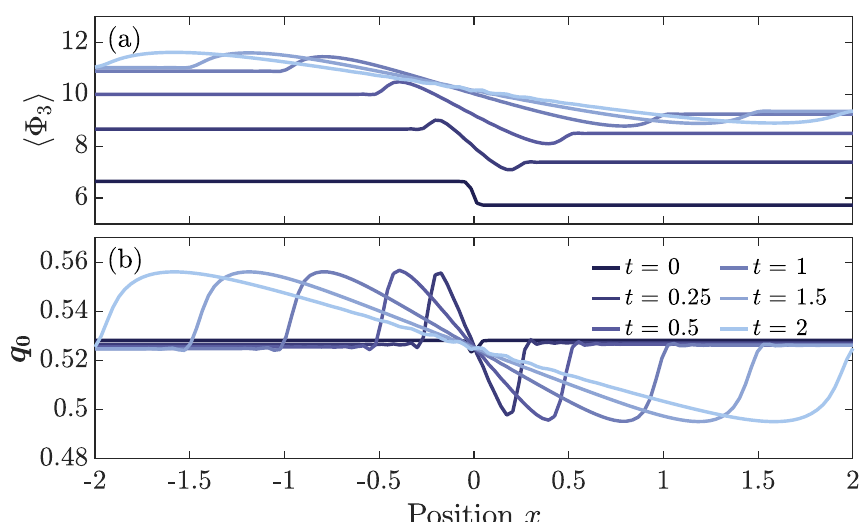
Figure 5: Partitioning protocol in relativistic sinh-Gordon model, where two homo- = 1.25 and T = 1.75 are joined geneous, semi-infinite leads of temperature T L R together at time t = 0. Additionally the interaction, α , is gradually increased. (a) ( x ) ≡ : e kg φ ( x ) : for k = 3 at different times. As Expectation of the vertex operator Φ k ( x ) 〉 . (b) Evolution of the linear density the interaction is increased globally, so is 〈 Φ 3 driven by the difference in temperature. Quasiparticles from the hot reservoir travel quickly into the cold reservoir creating an expanding density